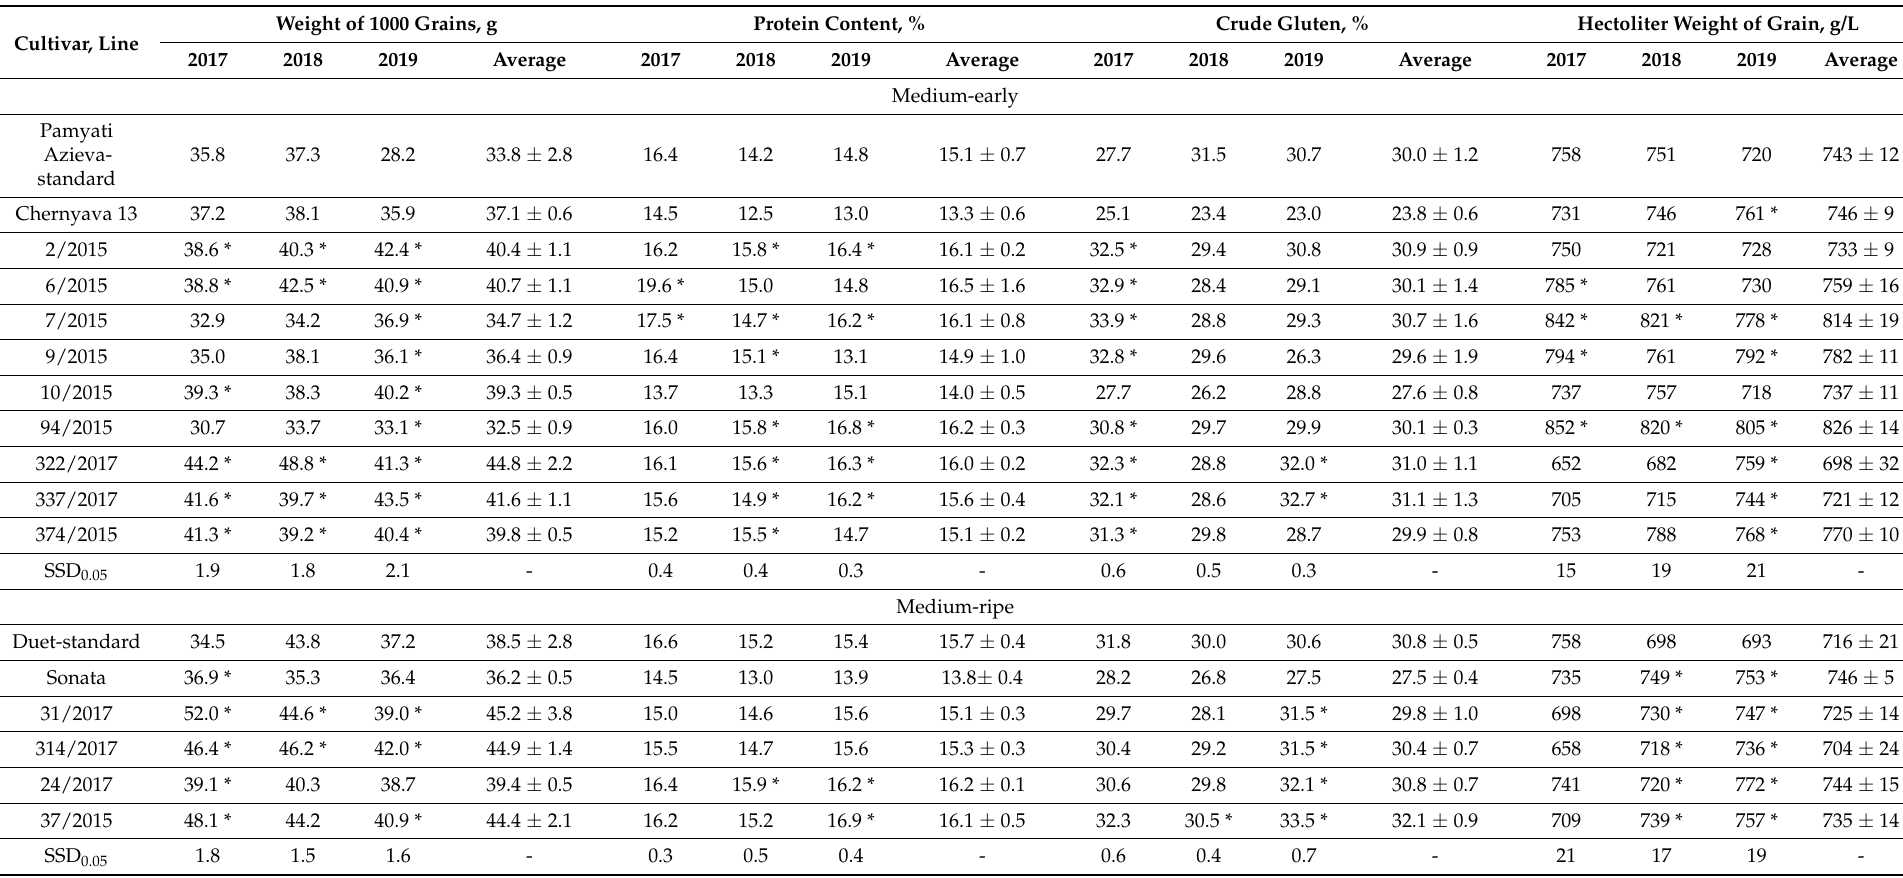
Table 4. Parameters of grain quality of spring common wheat cultivars and introgressive lines with genetic material of Thinopyrum ponticum and correlation with Septoria blotch severity (natural infection background, Omsk, Russia, 2017–2019). Weight of 1000 Grains, g Protein Content, % Crude Gluten, % Hectoliter Weight of Grain, Cultivar, Line